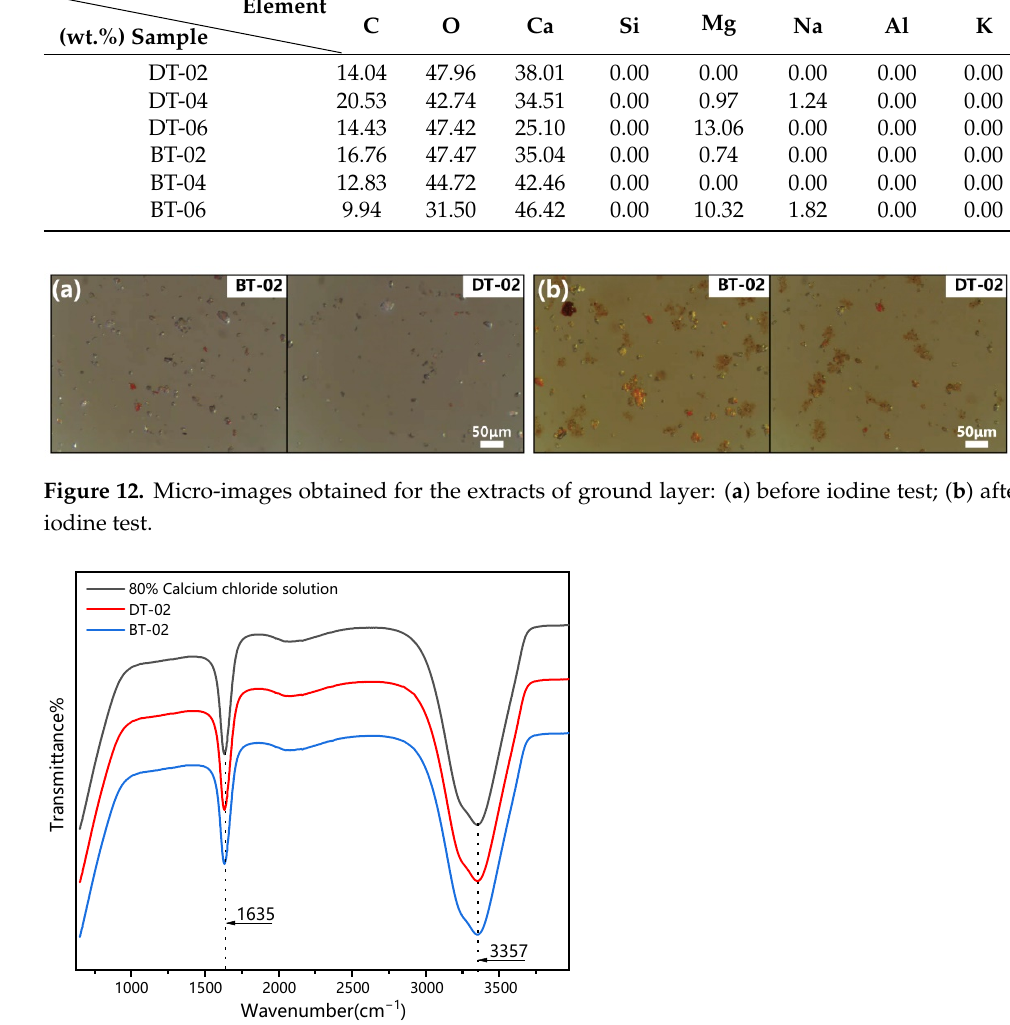
Table 2. Elemental compositions of the ground layer samples. (wt.%) Sample